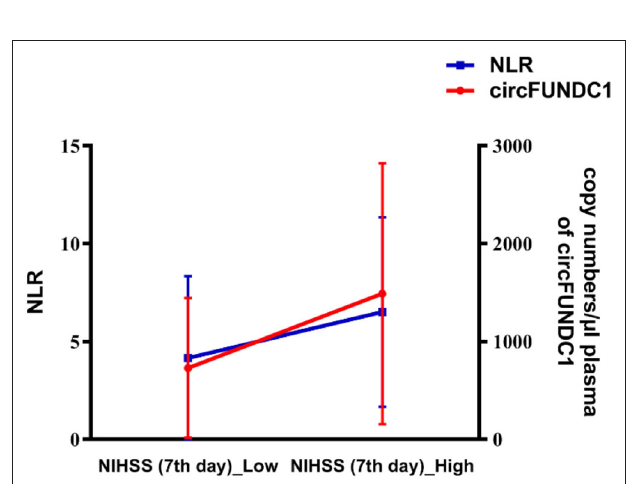
FIGURE 8 | Interactive effect of circFUNDC1 and NLR (neutrophil to lymphocyte ratio) on the seventh NIHSS scores in patients admitted within 24h after onset. NIHSS, National Institutes of Health Stroke Scale. Multiple linear regression analysis, P <